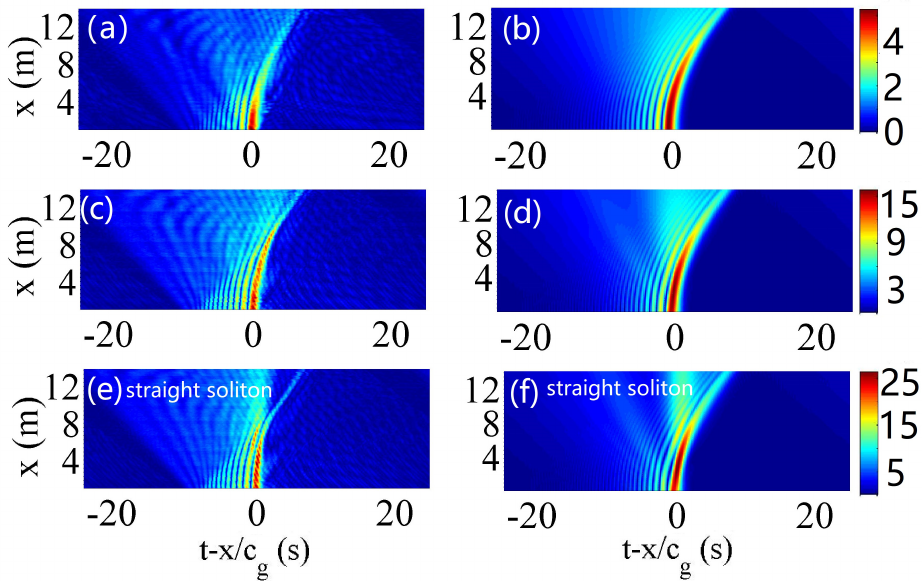
Figure 11. Evolution of Airy envelopes obtained from the experimental records by the Hilbert transform ( a , c , e ) and simulated using Equation (1) ( b , d , f ) with t 0 = 0.65 s and α = 0.1, in a frame of reference moving at velocity c g Measurements were performed at ( a , b ) a 0 = 5 mm, ε = 0.04, ( c , d ) a 0 = 17 mm, ε = 0.14, and ( e , f ) a 0 = 23 mm, ε =